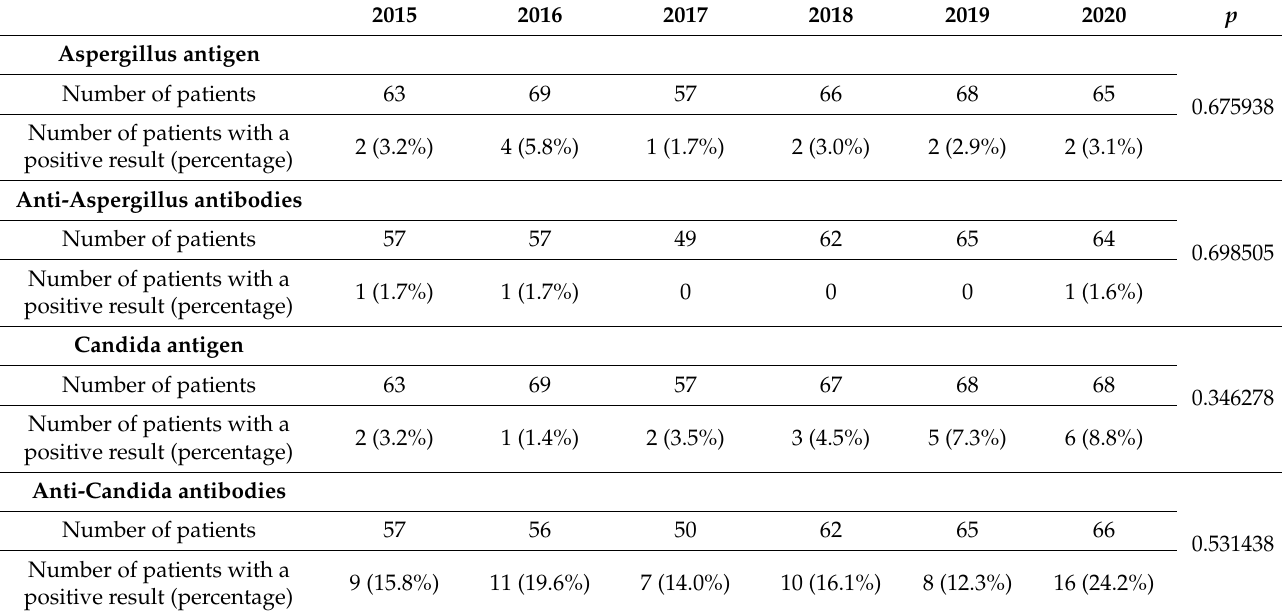
Table 6. Patients with positive results of serological testing each